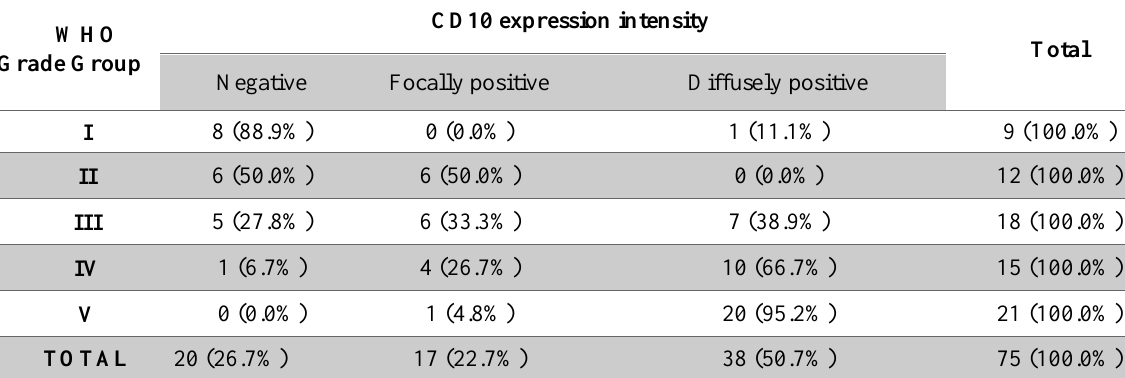
Table 2. Correlation between WHO Grade Group and intensity of CD10